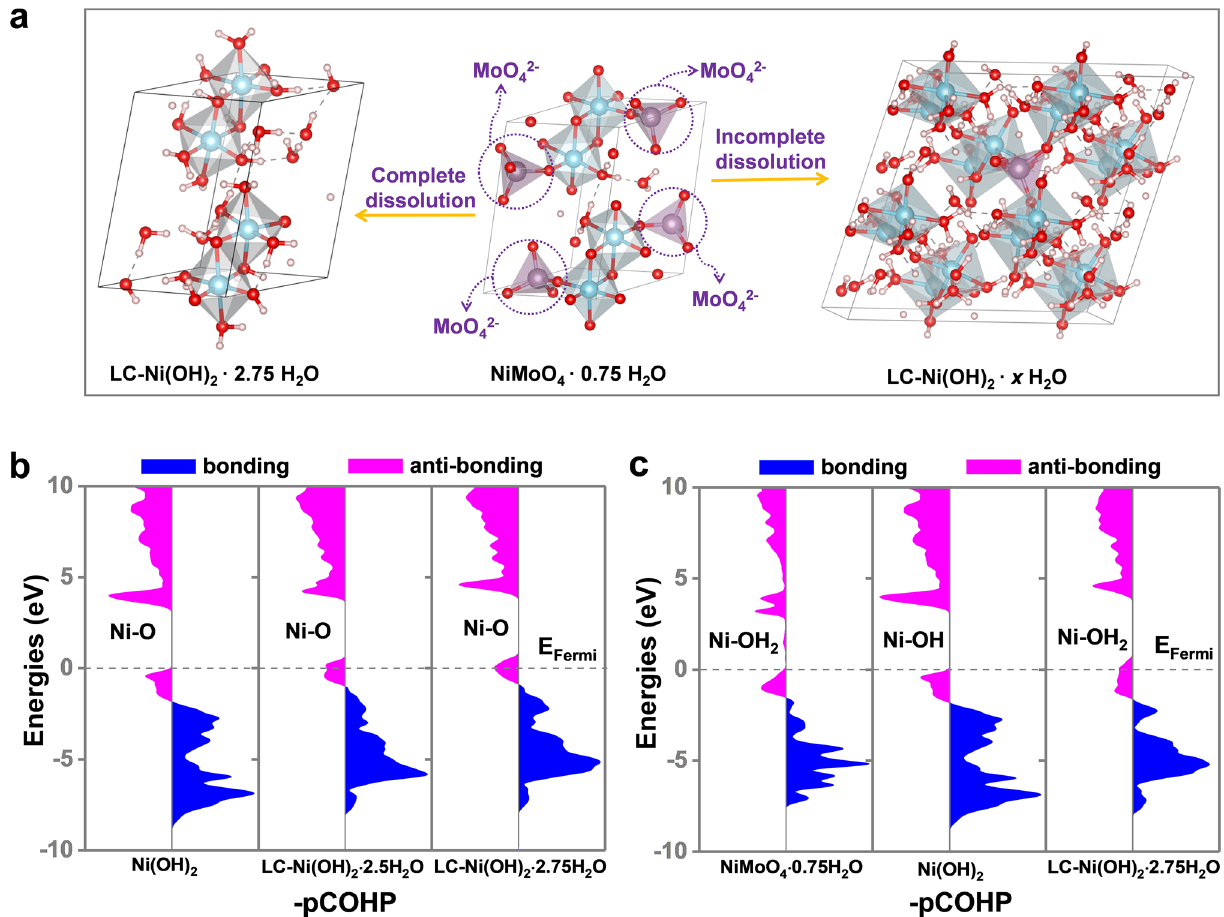
Fig. 5 a Illustration for the formation of LC‑Ni(OH) 2 ·2.75H 2 O and Mo‑doped LC–Ni(OH) 2 · x H 2 O from NiMoO 4 ·0.75H 2 O. b Crystal orbital Hamilton population (COHP) for all Ni–O bonds of Ni(OH) 2 , LC–Ni(OH) 2 ·2.50H 2 O and LC–Ni(OH) 2 ·2.75H 2 O. c Crystal orbital Hamilton pop‑ ulation (COHP) for active Ni–O bonds of NiMoO 4 ∙0.75H 2 O, Ni(OH) 2 and LC–Ni(OH) 2 ∙2.75H 2 O. ‑pCOHP refers the negative projected